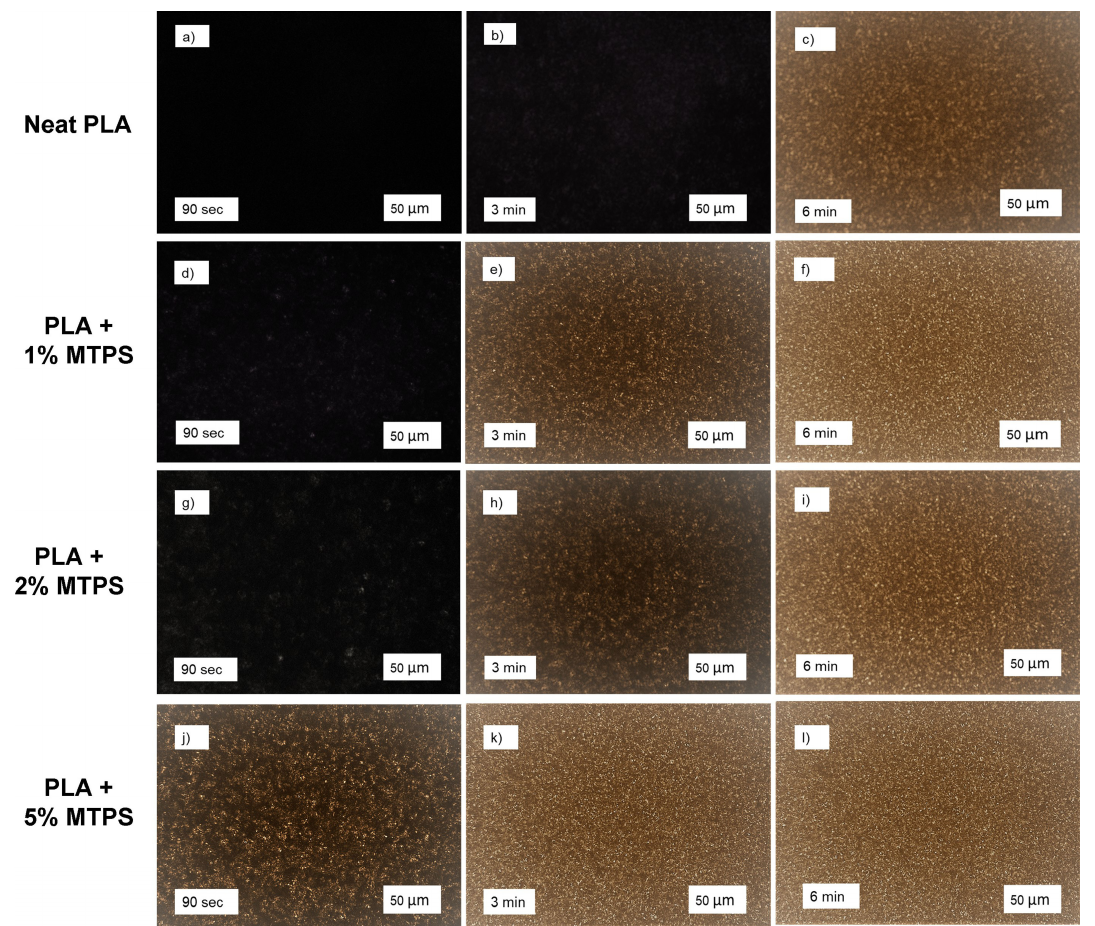
Figure 15. Polarized optical microscopy (POM) images of PLA/MTPS blends with MTPS content of 0%: ( a – c ); 1%: ( d – f ); 2%: ( g – i ); 5%: ( j – l ). Table 8. Crystallization half times and Avrami constants for PLA samples at different temperatures.